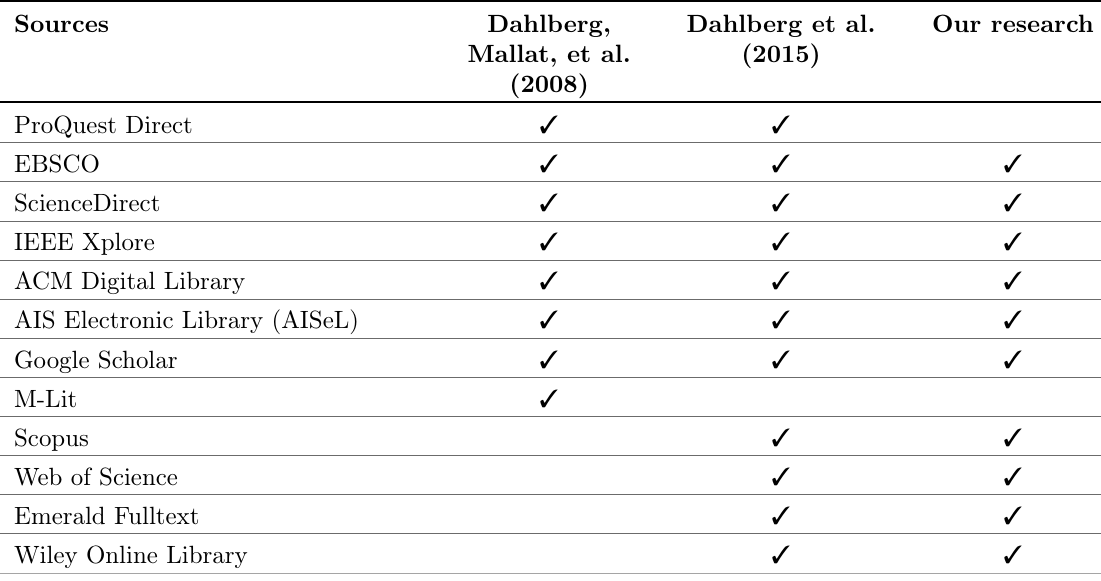
Table 2. A list of databases used for literature